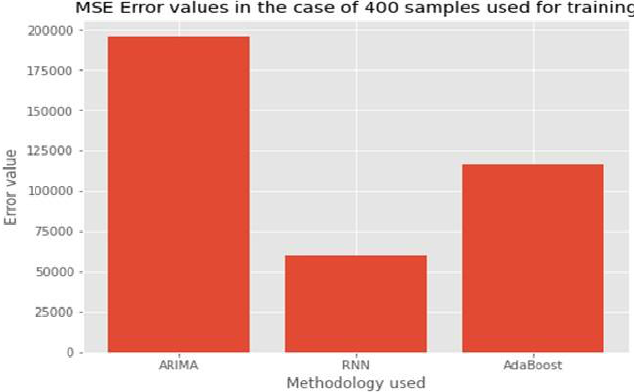
Figure 15. Comparing the MSE between RNN, ARIMA, and AdaBoost for 400